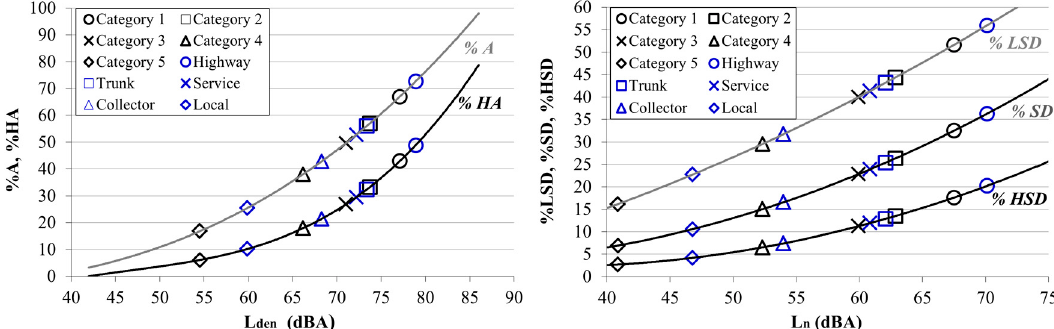
Figure 8. Percentages annoyance indicators (percentages of annoyed (% A ) and highly annoyed (% HA ) population; percentages of lowly sleep disturbed (% LSD ), sleep disturbed (% SD ) and highly sleep disturbed (% HSD ) population) obtained from the proposed equations [58,59] for road types and road categories.